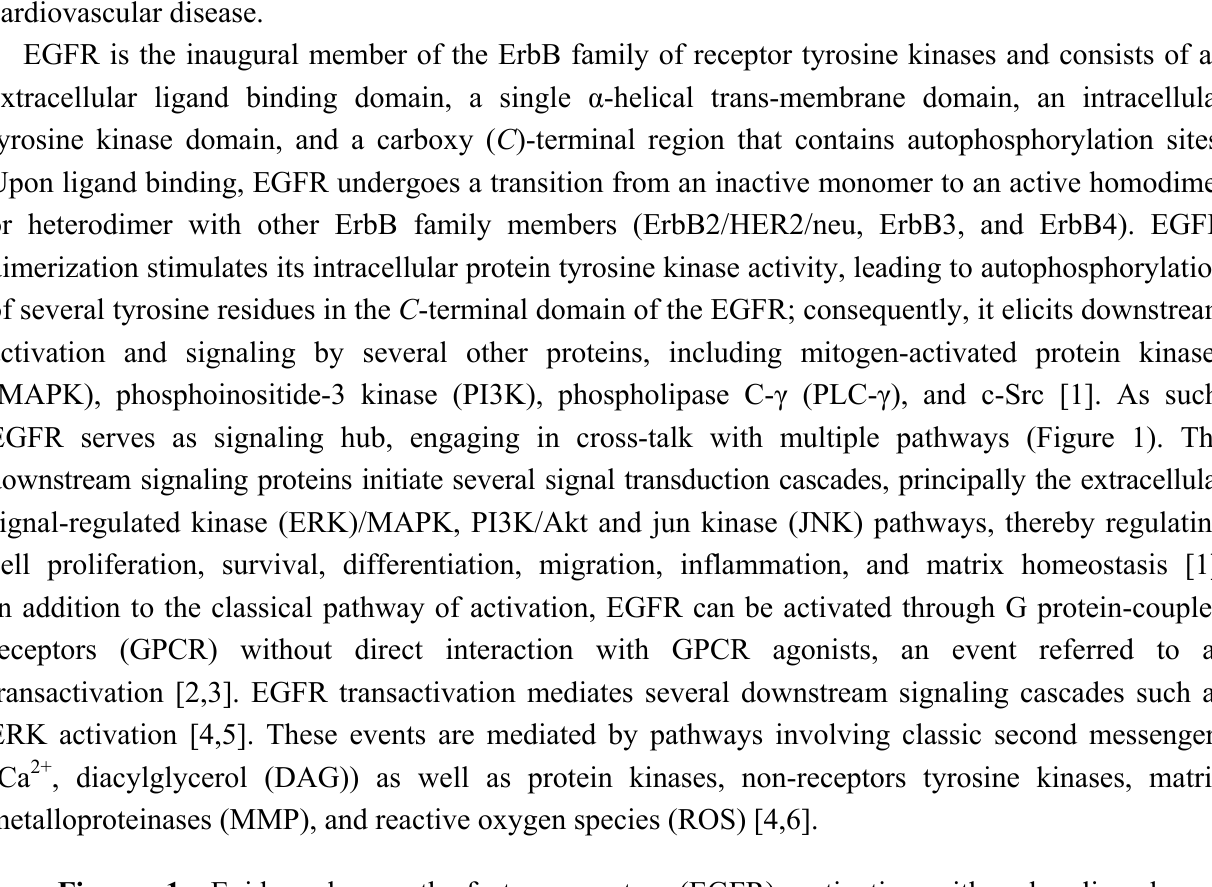
Figure 1. Epidermal growth factor receptor (EGFR) activation either by ligand binding or by transactivation mechanisms results in induction of several downstream signaling